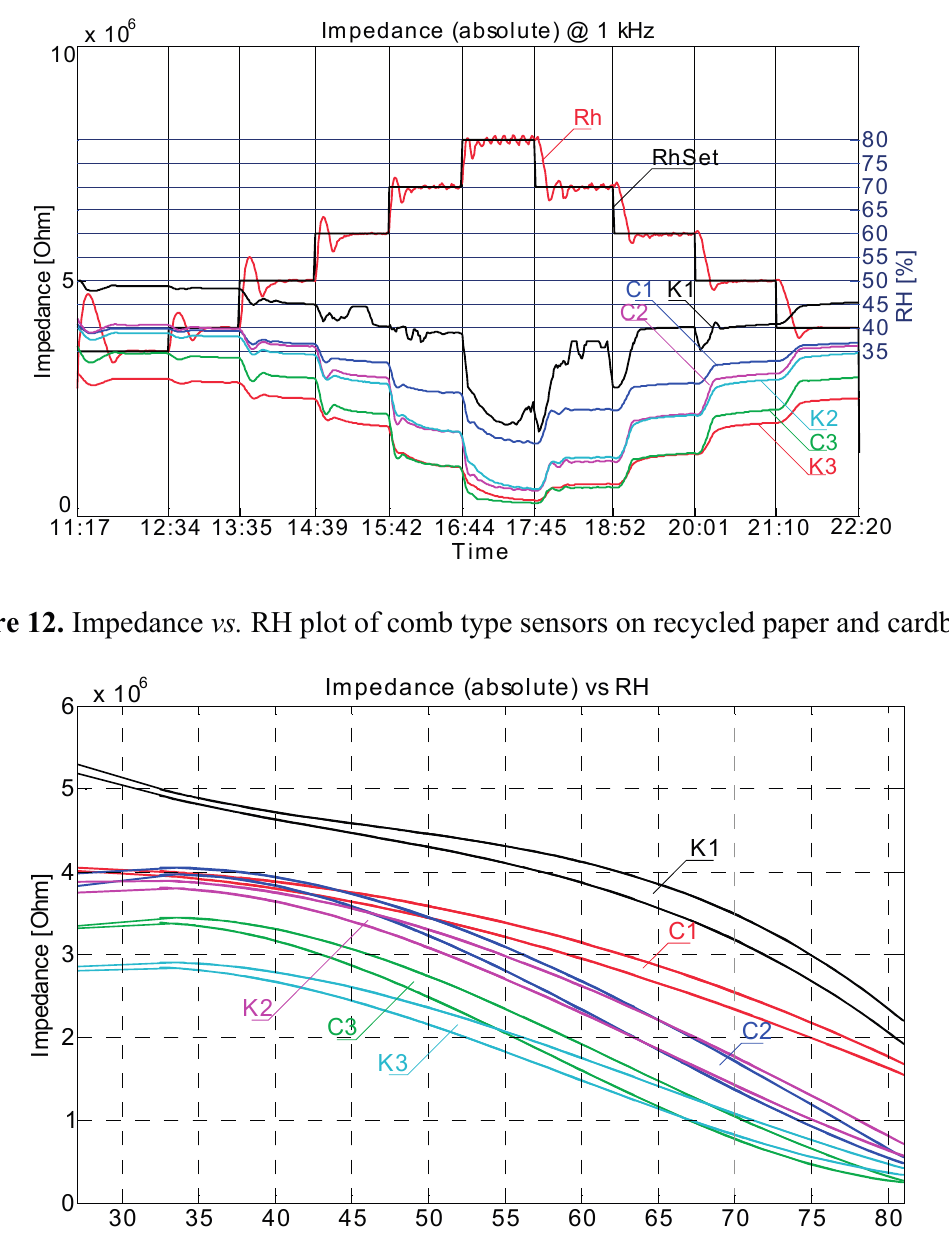
Figure 11. Impedance of comb type sensors on recycled paper and cardboard.